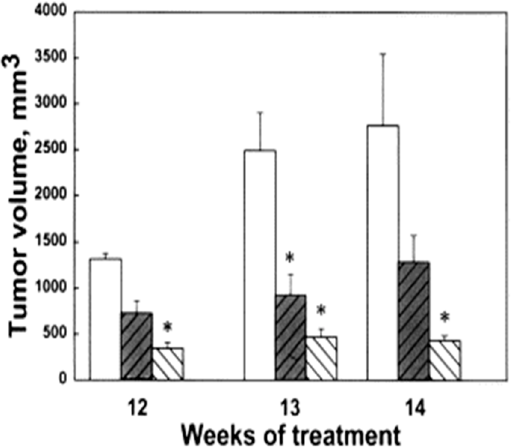
Figure 3. Effect of bis(ethyl)polyamines on tumor volume. The data presented are the average values determined on weeks 12, 13 and 14 of treatment of FVB/NTgN (MMTVneu) transgenic mice. Bars indicate control (unfilled bar), BE-3-3-3 treatment (darkened bar) and BE-3-3-3-3 treatment (striped bar) groups. * Statistically significant ( p < 0.05) compared with controls, as determined by ANOVA followed by Dunnett’s test. Reproduced with permission from [66].